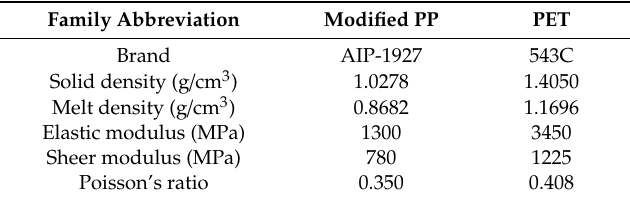
Table 1. Physical properties of the materials.